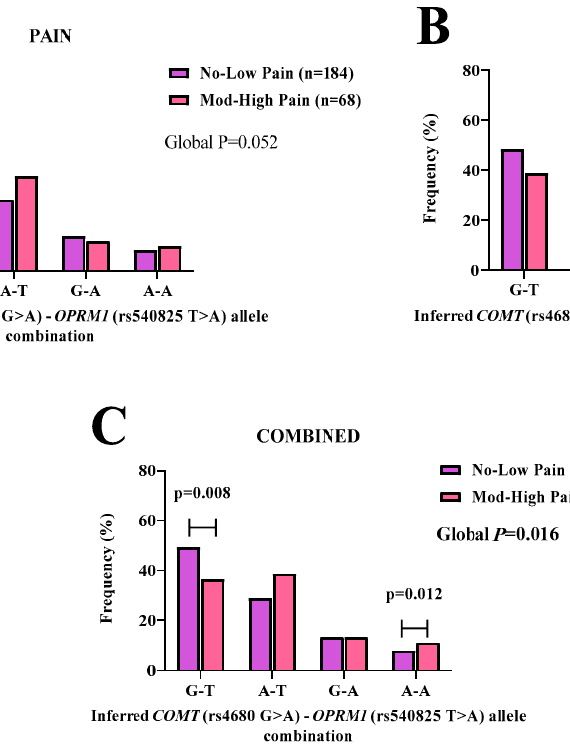
Figure 4. The inferred COMT (rs4680 G > A)- OPRM1 (rs540825 T > A) allele–allele combinations’ frequency distribution patterns are shown for ( A ) pain, ( B ) disability, and ( C ) combined (pain and disability) symptoms in SA BCS. No-low (purple bars) and moderate-high (pink bars) groups are displayed with the number of participants in parenthesis (n). Statistically significant ( p < 0.05) frequency differences are noted with an age-adjusted p -value in bold .